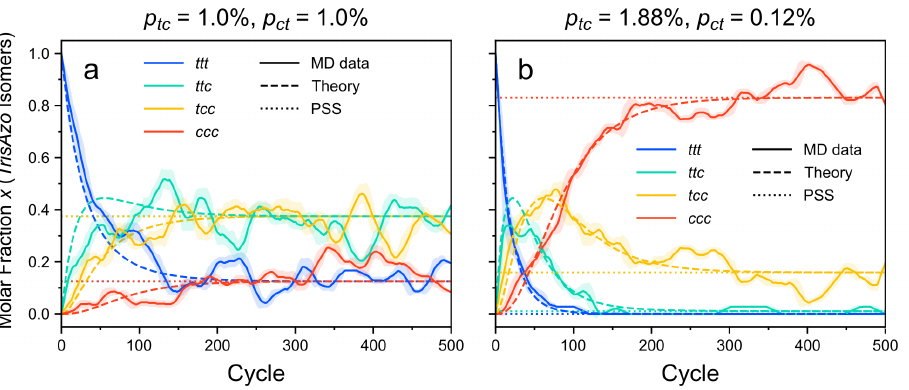
Figure 5. Molar fractions of the four different TrisAzo isomers with respect to all TrisAzo molecules as p ct , like in the experiments of Kind et al. [83]. MD data a function of time. ( a ) p tc = p ct . ( b ) p tc = 15 2 3 are represented by solid lines. The meaning of the line styles and the settings of the running average are the same as in Figure